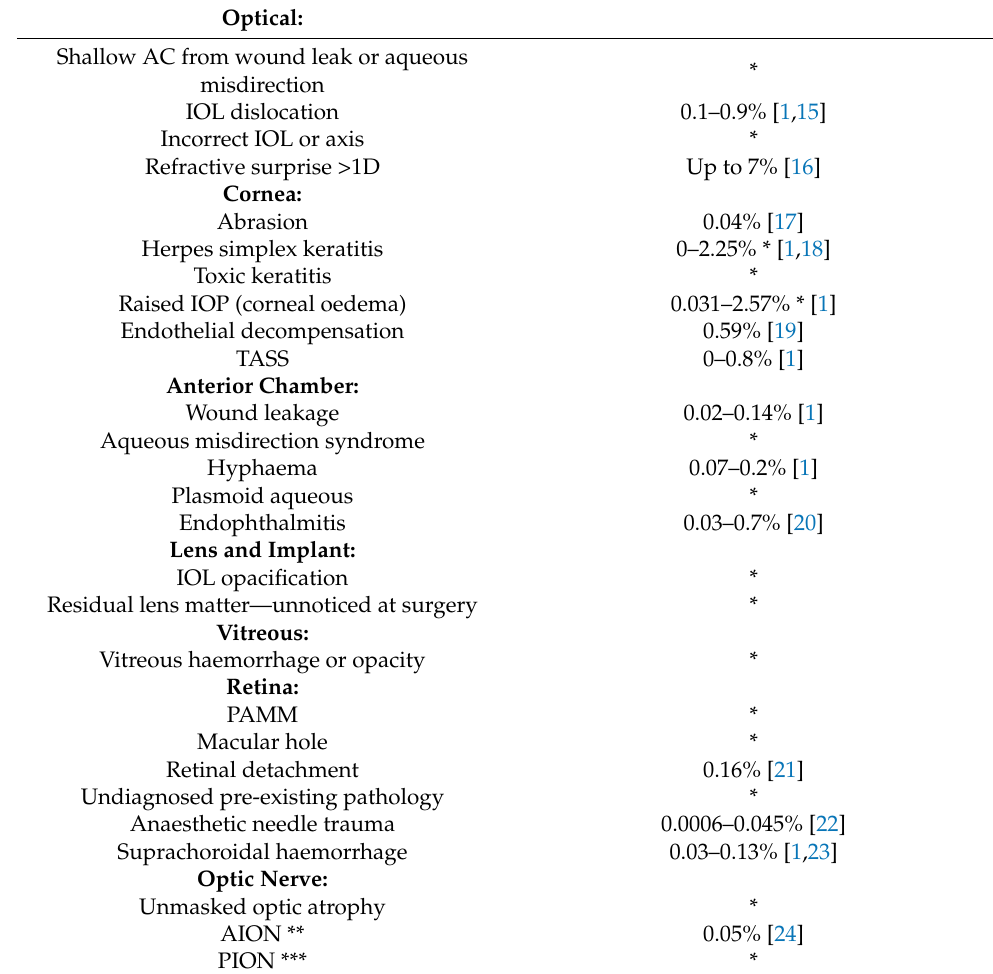
Table 1. Incidence of complications causing visual loss within 24 h of uncomplicated cataract